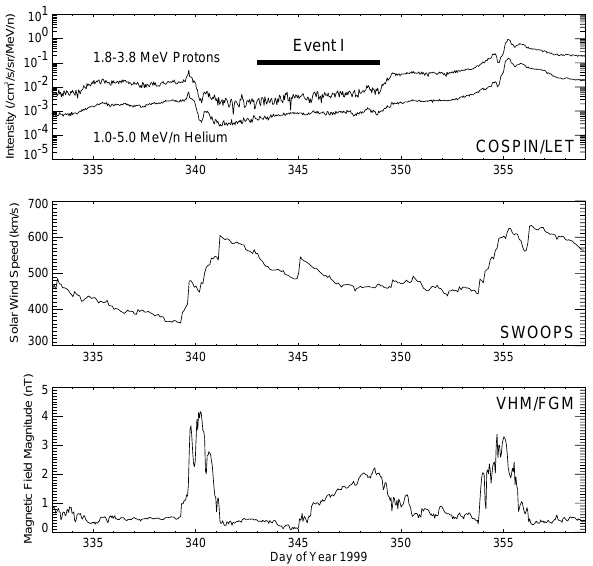
Fig. 2. The Ulysses trajectory plotted as a function of heliocentric distance and helio-latitude from launch in (October 1990) to May 2002. The second orbit is slightly displaced from the true orbit, in order to separate it from the first pair of polar passages for clarity. Colour-coded along the Ulysses trajectory is the PHA derived 4–6 MeV/n helium intensity measured by the COSPIN/LET instrument. The 12 periods of 3 He enrichments identified in this study have been labelled as events A to L on this diagram. Events A–G took place during the in-ecliptic transfer to Jupiter (launch to February 1992), and the remaining events (H–L) were during the high-latitude phase of the mission.